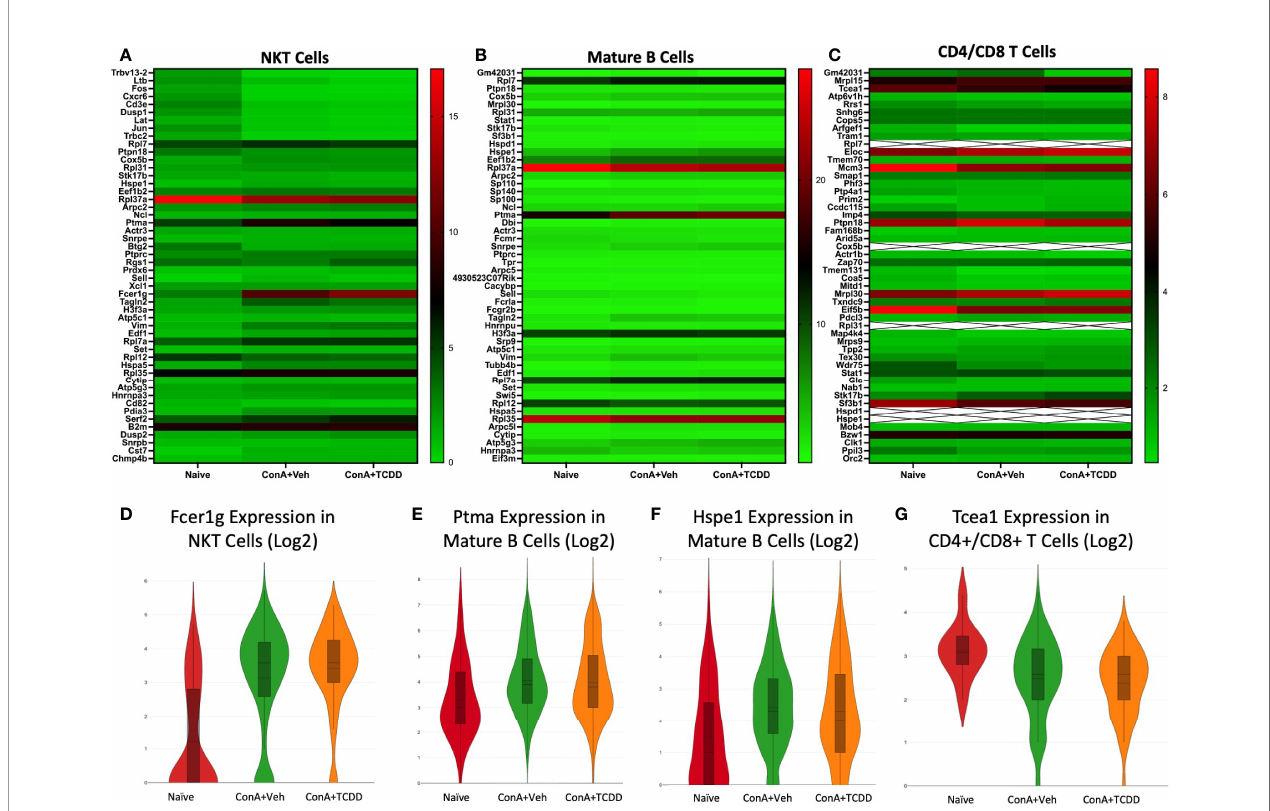
FIGURE 4 | Analysis of changes in gene expression in NKT, Mature B cells, and CD4/CD8 T cell clusters. C57/BL6 mice were injected with ConA followed by vehicle or TCDD 1 hour later as described in Figure 1 legend. Liver in fi ltrating cells were isolated and scRNA-seq was performed as described in Methods. Heatmaps consisting of the top 50 differentially expressed genes per treatment were generated using Loupe Browser. Heatmaps of differentially expressed genes from (A) NKT, (B) Mature B, and (C) CD4/CD8 T cells. In panel (C) , the X marked with some genes represents an expression level over 20. (D-G) Violin plot of Log2 expression of target